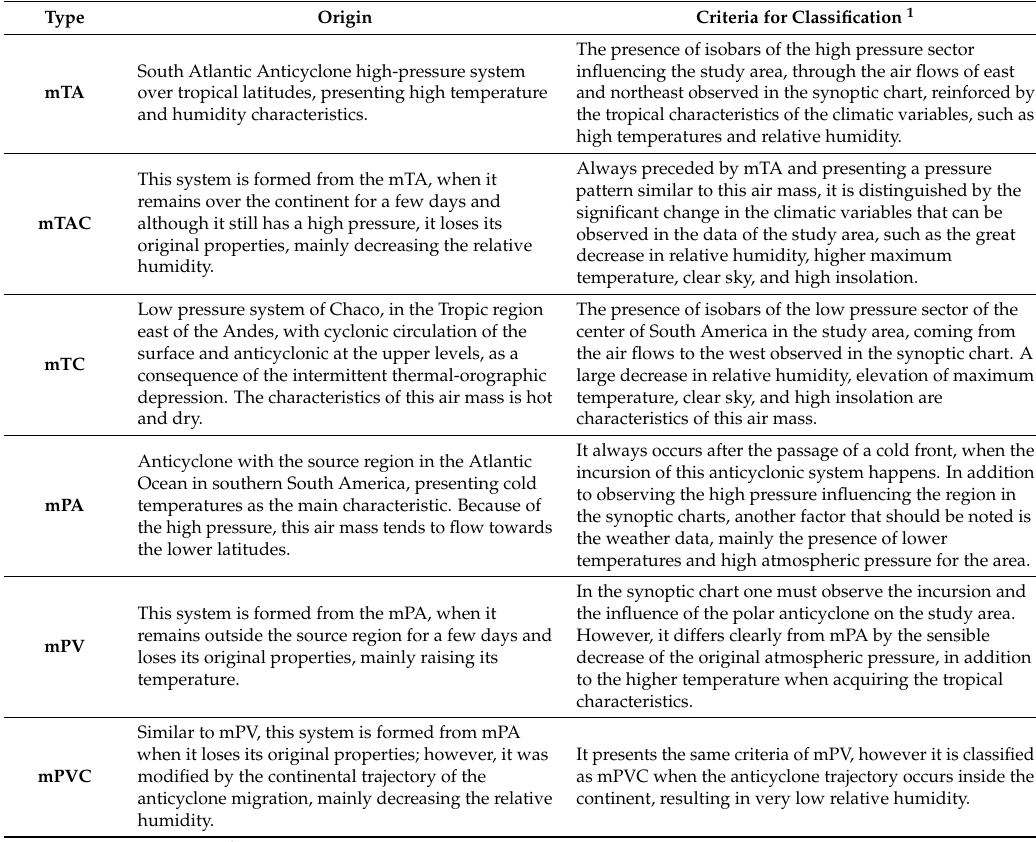
Table 2. Air masses: origin and criteria for